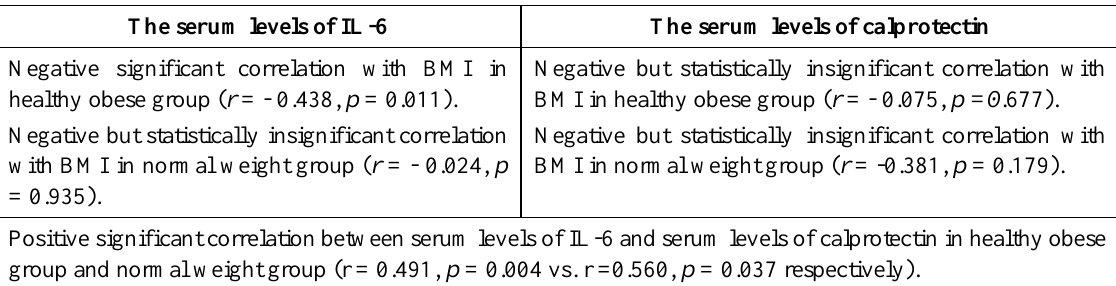
Table 3. Correlations between serum levels of IL-6, BMI and calprotectin. The serum levels of IL-6 Negative significant correlation with BMI in healthy obese group ( r = - 0.438, p =